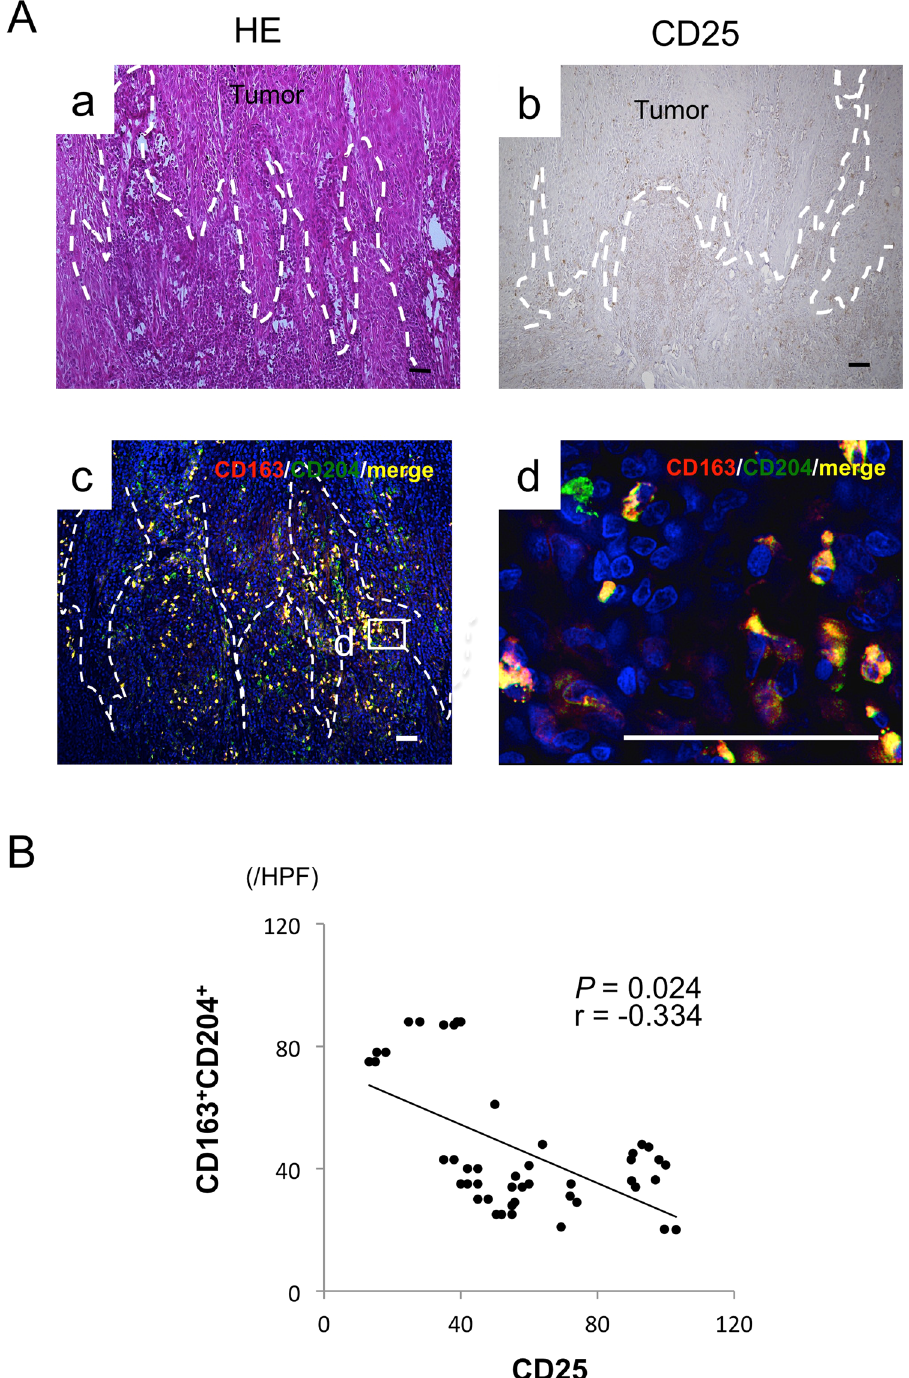
Figure 2. Co-localization of TAM markers in OSCC patients. ( A ) Representative images of paraffin sections in/around tumor stained with H&E (a) and CD25 (b) antibodies (brown). Counterstaining with Mayer’s hematoxylin is shown in blue. Double immunofluorescence staining performed with CD163 (red), CD204 (green), and DAPI for staining nuclei (blue) at low (c) and high magnification (d). (c,d) Merged CD163 and CD204 images (yellow). Scale bars, 50 μ m. ( B ) Correlation between the number of CD163 + CD204 + and CD25 + cells in 46 OSCC patients. Statistically significant differences between groups were determined by Spearman’s rank